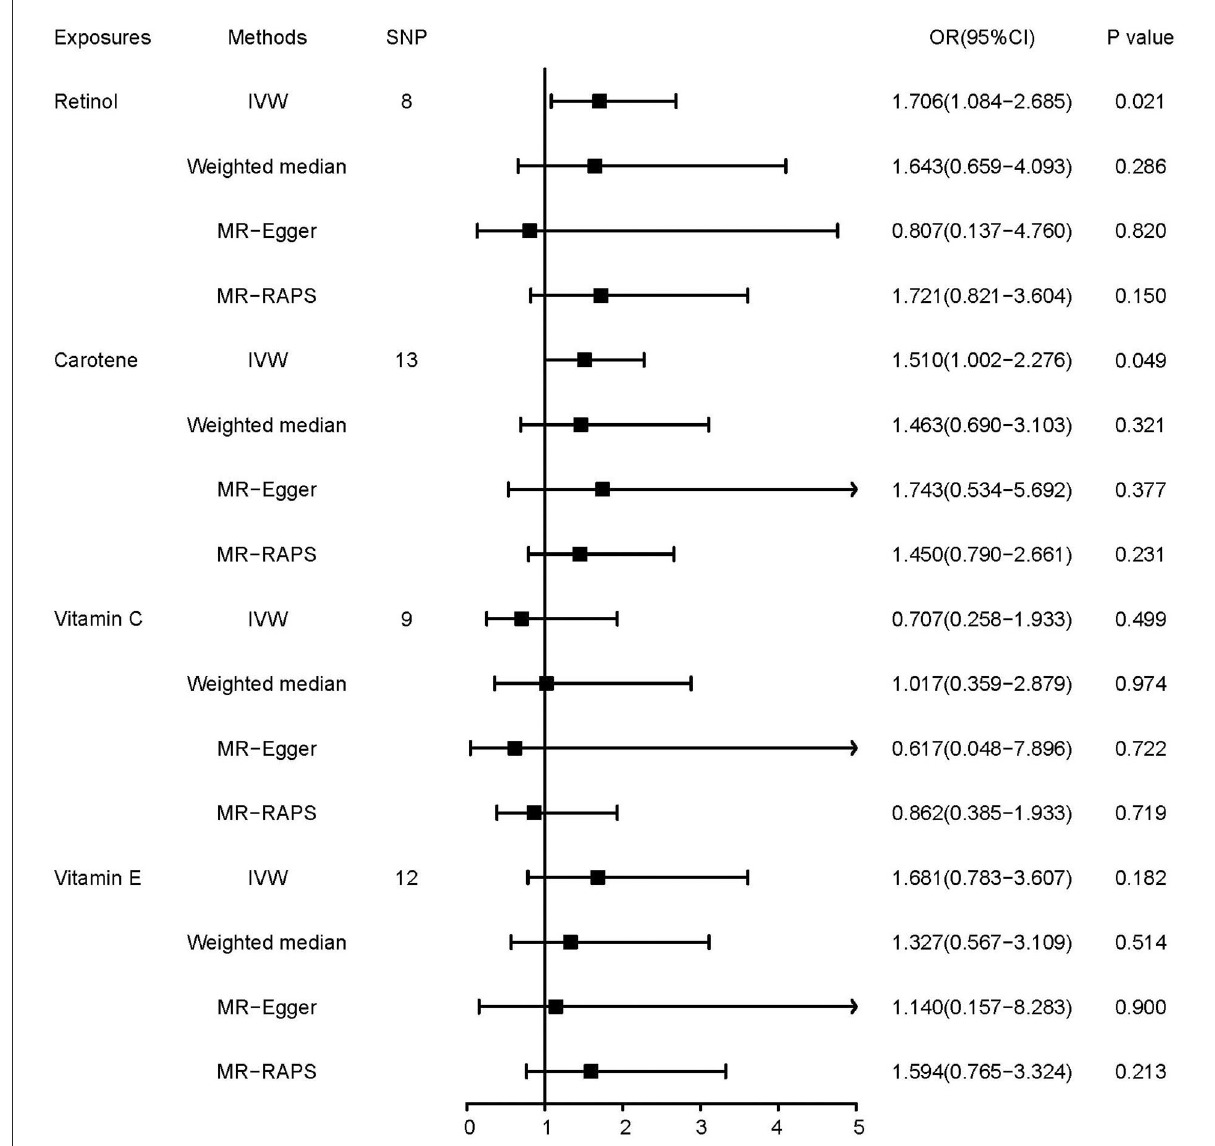
FIGURE3 Mendelian randomization estimates of the associations of antioxidant vitamins with lung